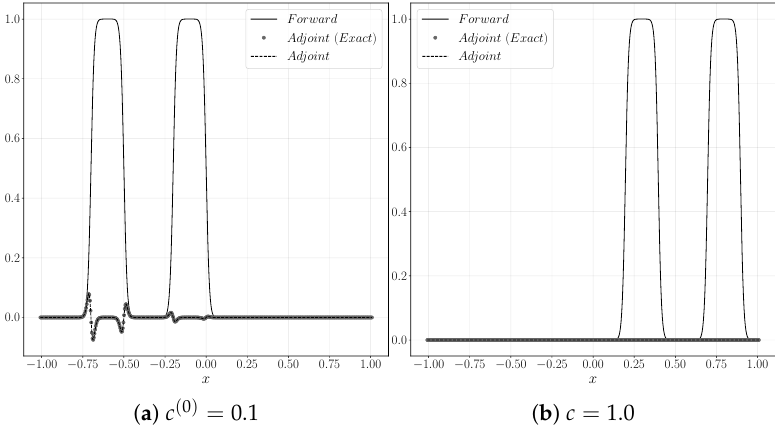
Figure 3. Solution at time t = T for the initial guess c ( 0 ) = 0.1 and the optimal solution c = 1.0.